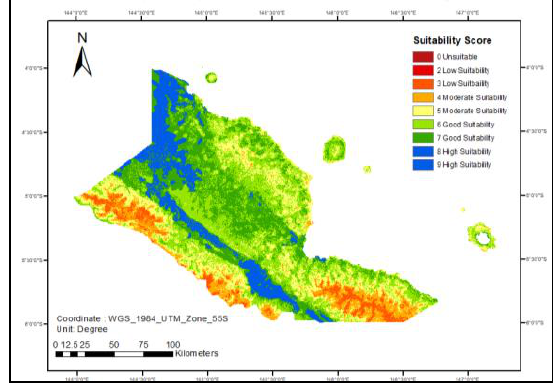
Figure 10. Agricultural land-use suitability map of general AHP